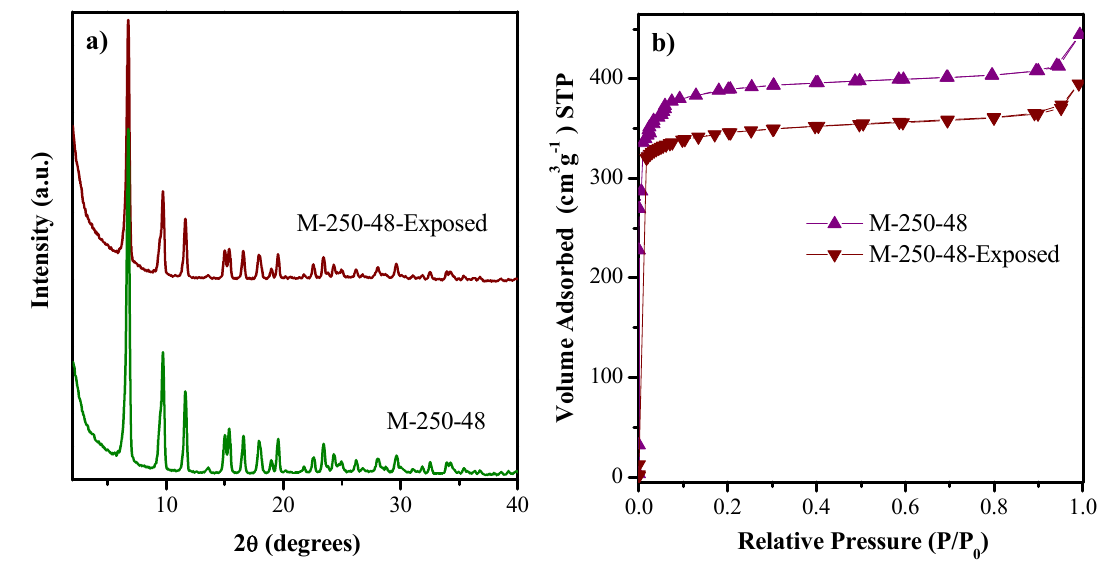
Figure 11. a ) XRD patterns and b ) N 2 adsorption–desorption isotherms at −196 °C of M-250-48 before Figure 11. ( a ) XRD patterns and ( b ) N 2 adsorption–desorption isotherms at − 196 ◦ C of M-250-48 before and after contact with water for 24 h. and after contact with water for 24